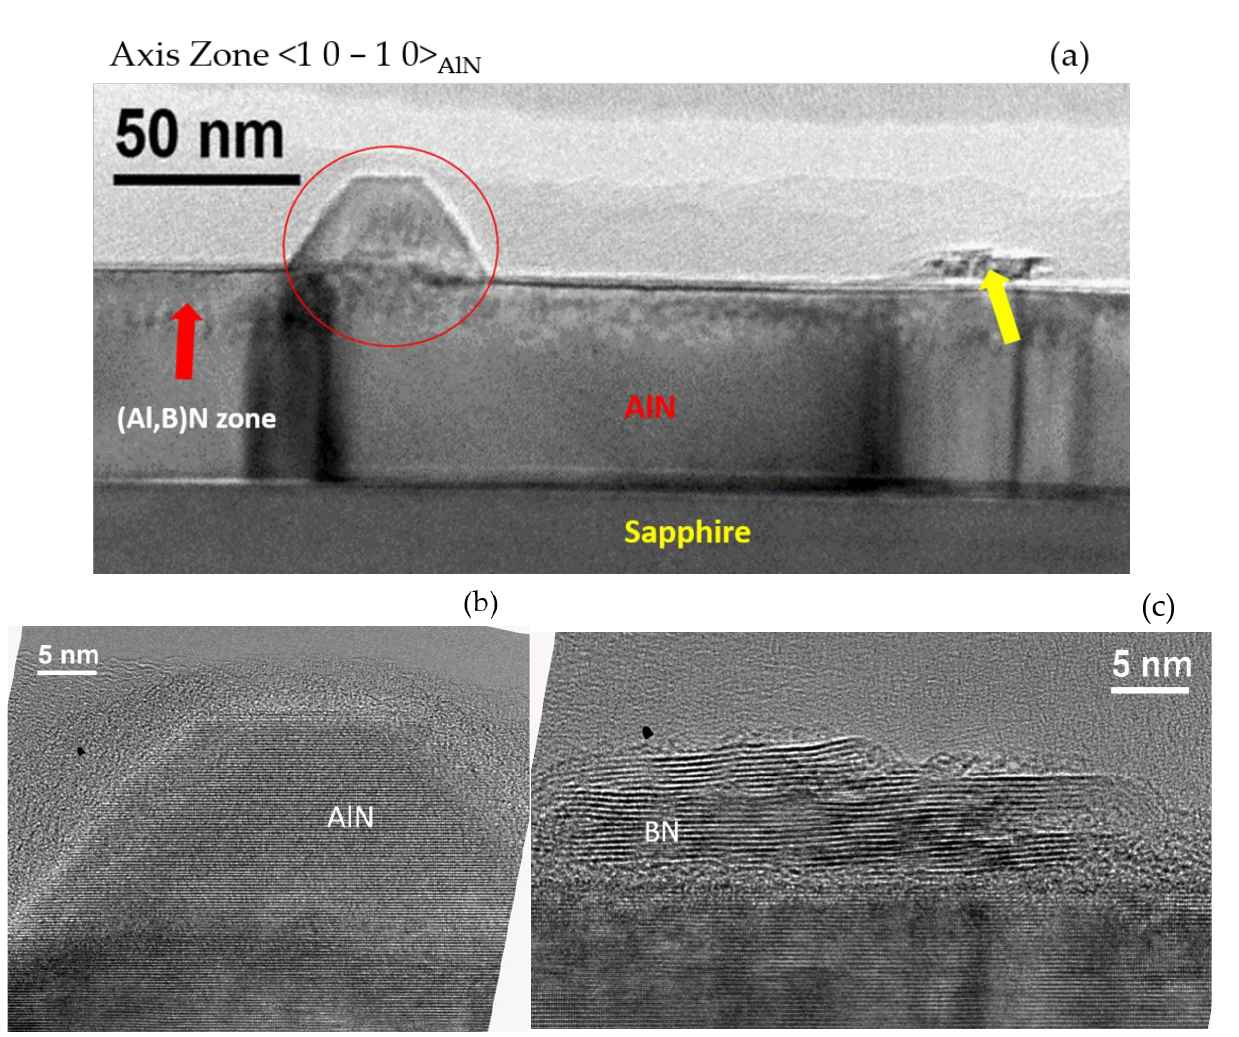
Figure 8. ( a ) AlN truncated pyramid-like structure at the surface (red circle). The yellow arrow points to a region made of h-BN due to the diffusion of B into the AlN layer, which reached the surface and recrystallized after annealing. The red arrow shows a specific contrasted region underneath the surface, which can be attributed to the presence of B in the AlN layer forming an (Al, B)N material. ( b , c ) High-resolution images of AlN truncated pyramid-like structure and recrystallized h-BN region, respectively.